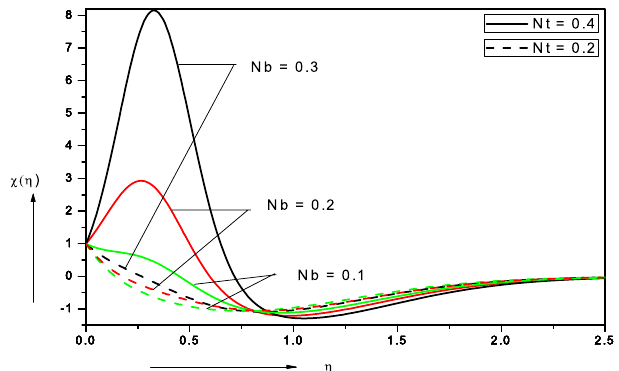
Figure 8. Effect of Brownian motion parameter ( Nb ) on motile microorganism density number.